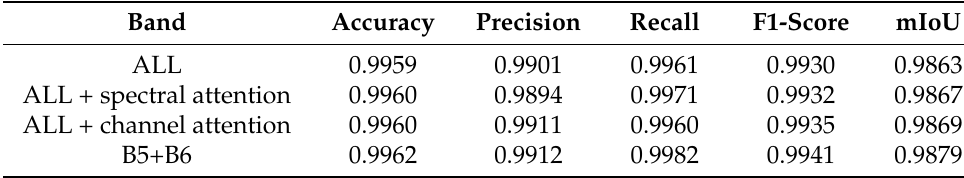
Table 4. Performance on all bands with different attention